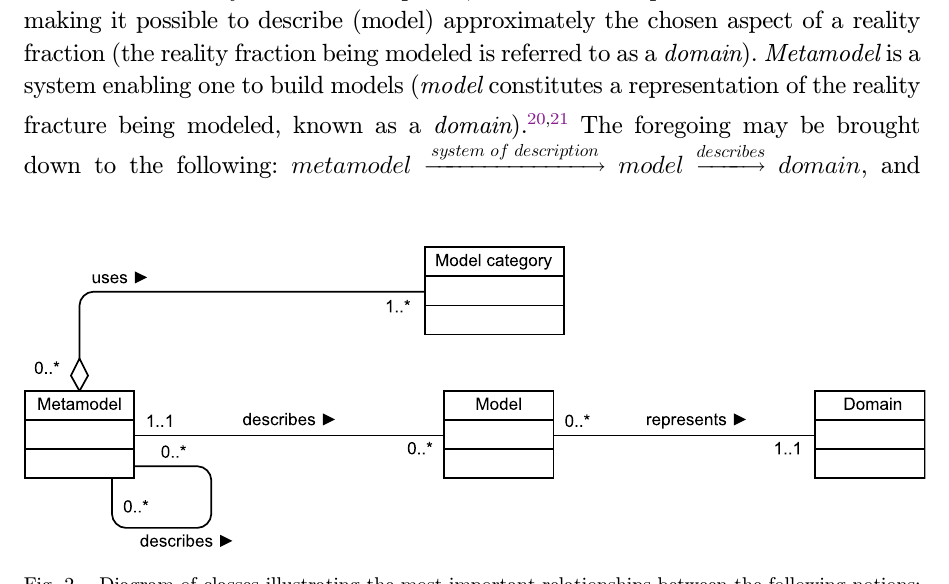
Fig. 2. Diagram of classes illustrating the most important relationships between the following notions: metamodel , model , domain , model primitive